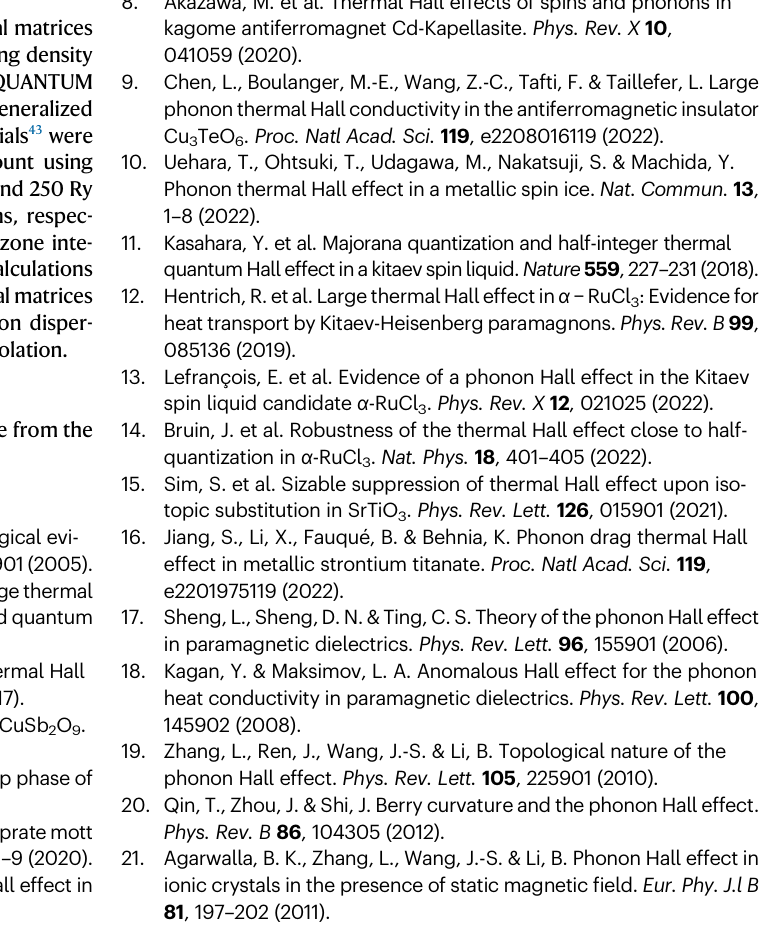
Fig. 4 | Phonons in black phosphorus. a Calculated phonon spectrum 34 below 100cm − 1 . The three acoustic branches are plotted with different colors. This spectrum, fi rst calculated in ref. 34 is in agreement with a recent X-ray experimental study 48 . b Angledependenceofthephononwave-vectorswithafrequencyof20cm − 1 projectedinthe xz plane.Thelongitudinalmode(inblack)andatransversemode(in